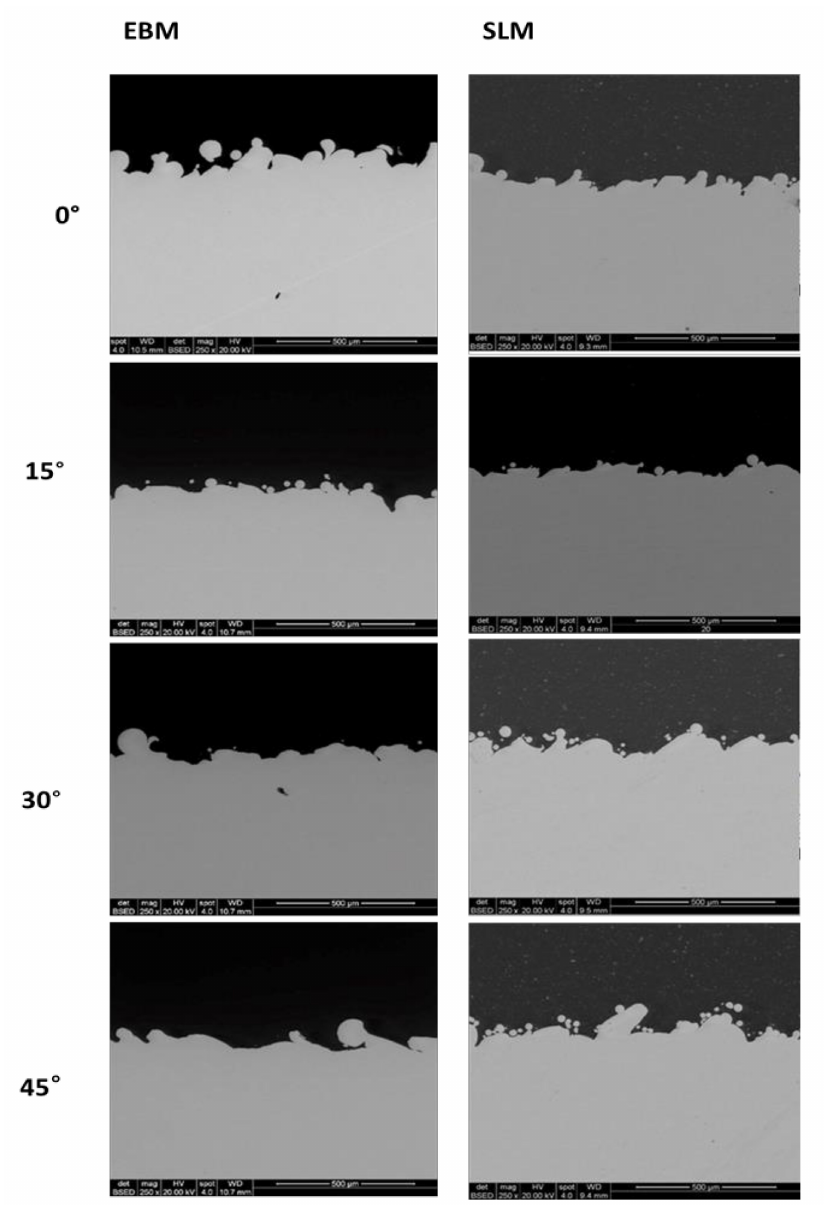
Figure 5. Micrographs (250x, scale bar is 500 µ m) illustrating the surface topography of the cross-sections of the EBM and SLM samples built at di ff erent building